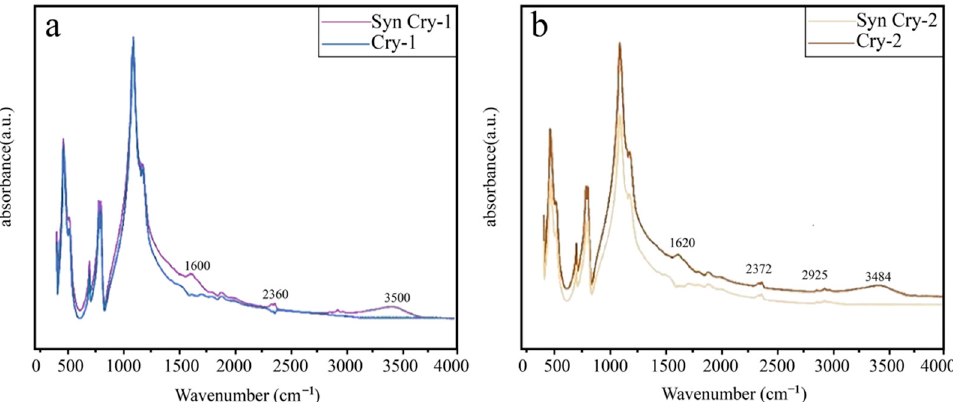
Figure 3. The infrared reflection spectra of Cry-1 and Syn Cry-1 samples ( a ), and the infrared reflection spectra of Cry-2 and Syn Cry-2 samples ( b ).